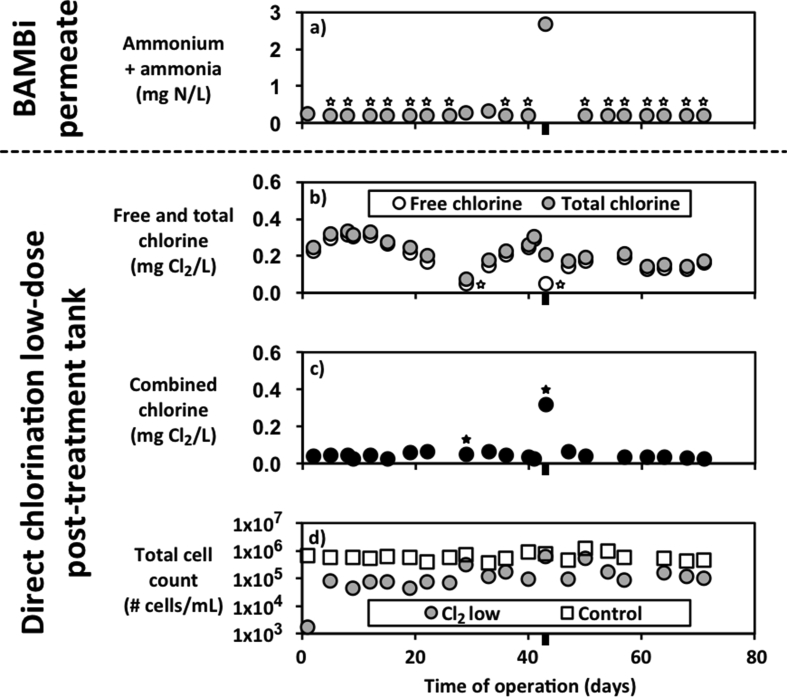
BAMBi permeate quality (a) is linked to chlorine (b, c) and TCC (d) concentrations in the low dose direct chlorination tank. Measurements below quantification are plotted as the quantification limit and indicated using a white-filled star placed below the data point. Black-filled stars are placed below values calculated using the quantification limit as the free chlorine value. Black bars beneath the x-axis indicate an interruption in aeration.